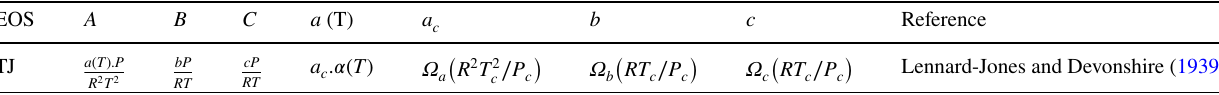
Table 12 TJ EOS parameters